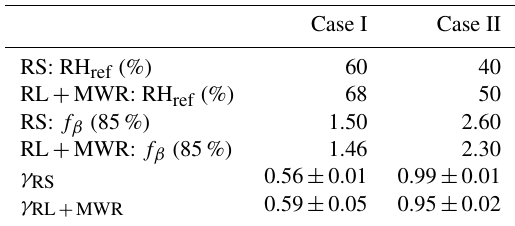
Table 2. Results obtained for each case analyzed by means of the new methodology combining RL + MWR and the classical ap- proach using RS